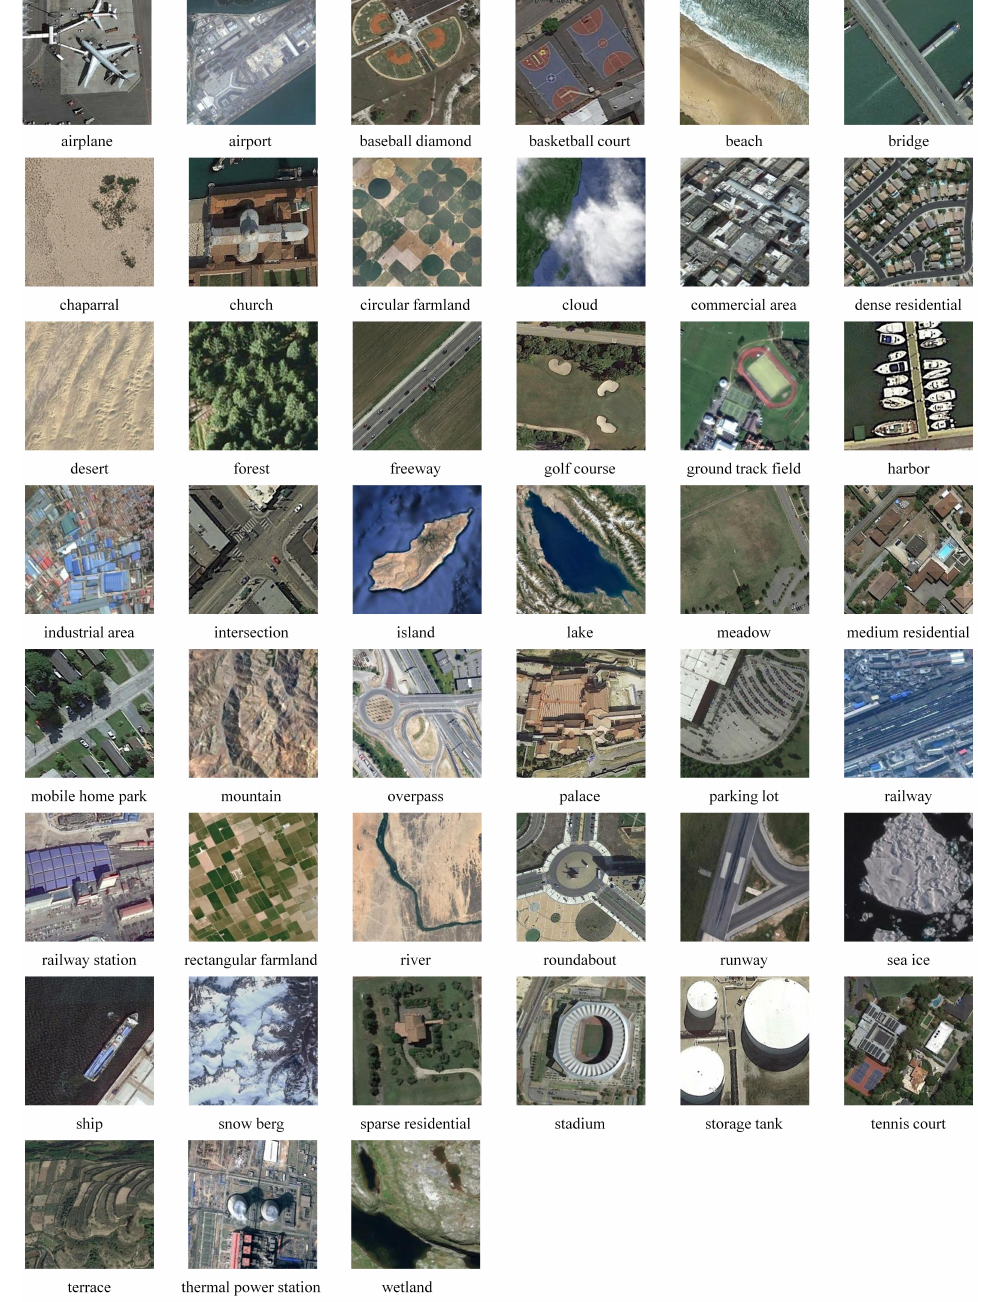
Figure 7. Some samples of the NWPU-RESISC45